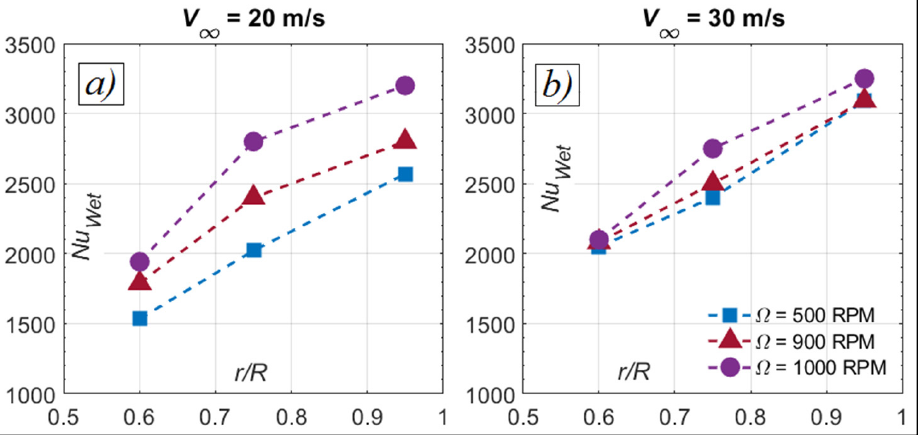
Figure 10. Variation in the Calculated Nu Wet with Respect to r/R for the Anti-Icing Tests at ( a ) V ∝ = 20 m/s and ( b ) V ∝ = 30 m/s.